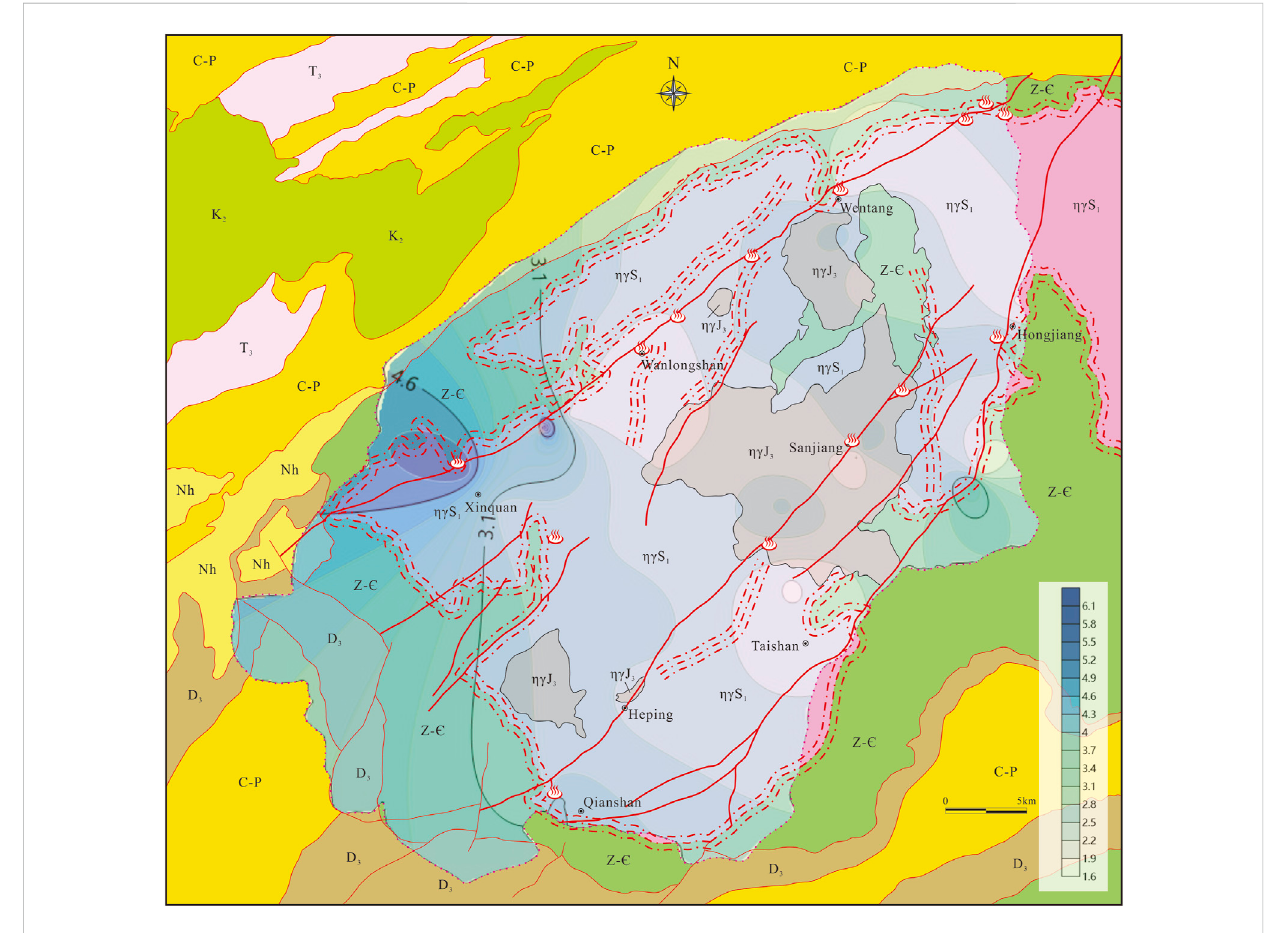
FIGURE 6 Histograms of speci fi c heat capacities in the Wugongshan